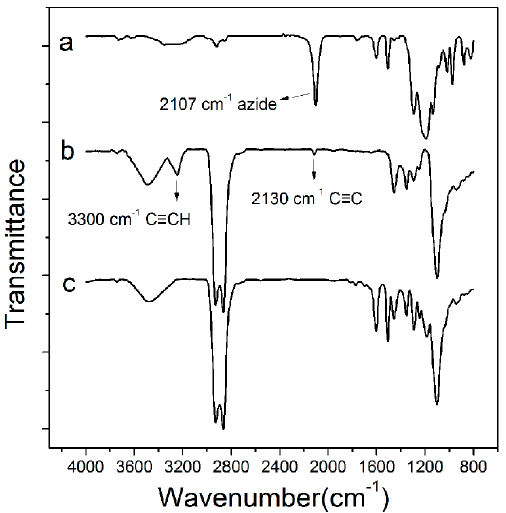
Figure 2. Grazing incidence reflectance (GIR) spectra of the N 3 -Ar-O-C 9 F 17 (curve a ), the binary OEG-SAM (curve b ), and the FS-SAM (curve c ).